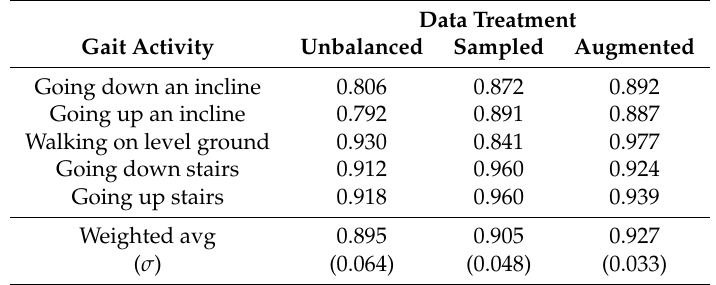
Table 10. F-measures for all gait activities using CNN model from unbalanced, sampled and augmented